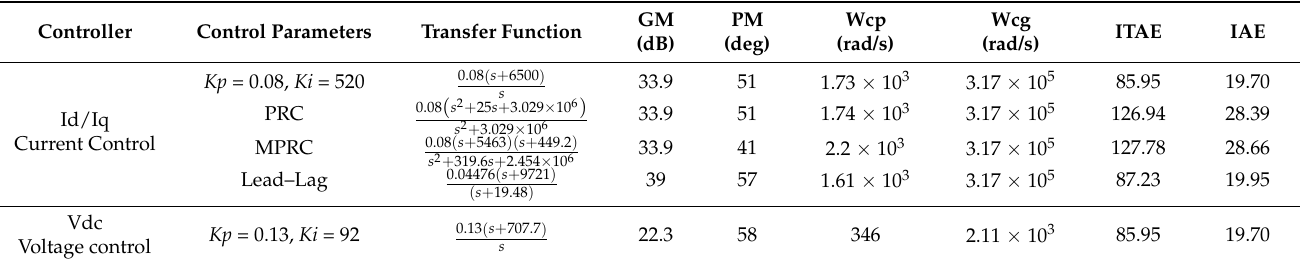
Table 3. Controller design parameters.